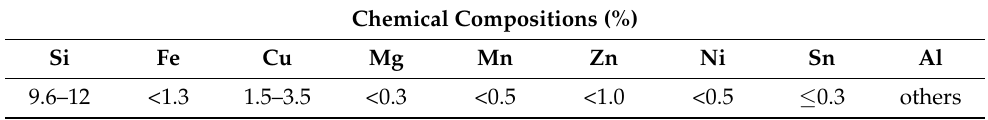
Table 1. Compositions of the Aluminum-Alloy Die Castings 12 (ADC12) aluminum alloy.